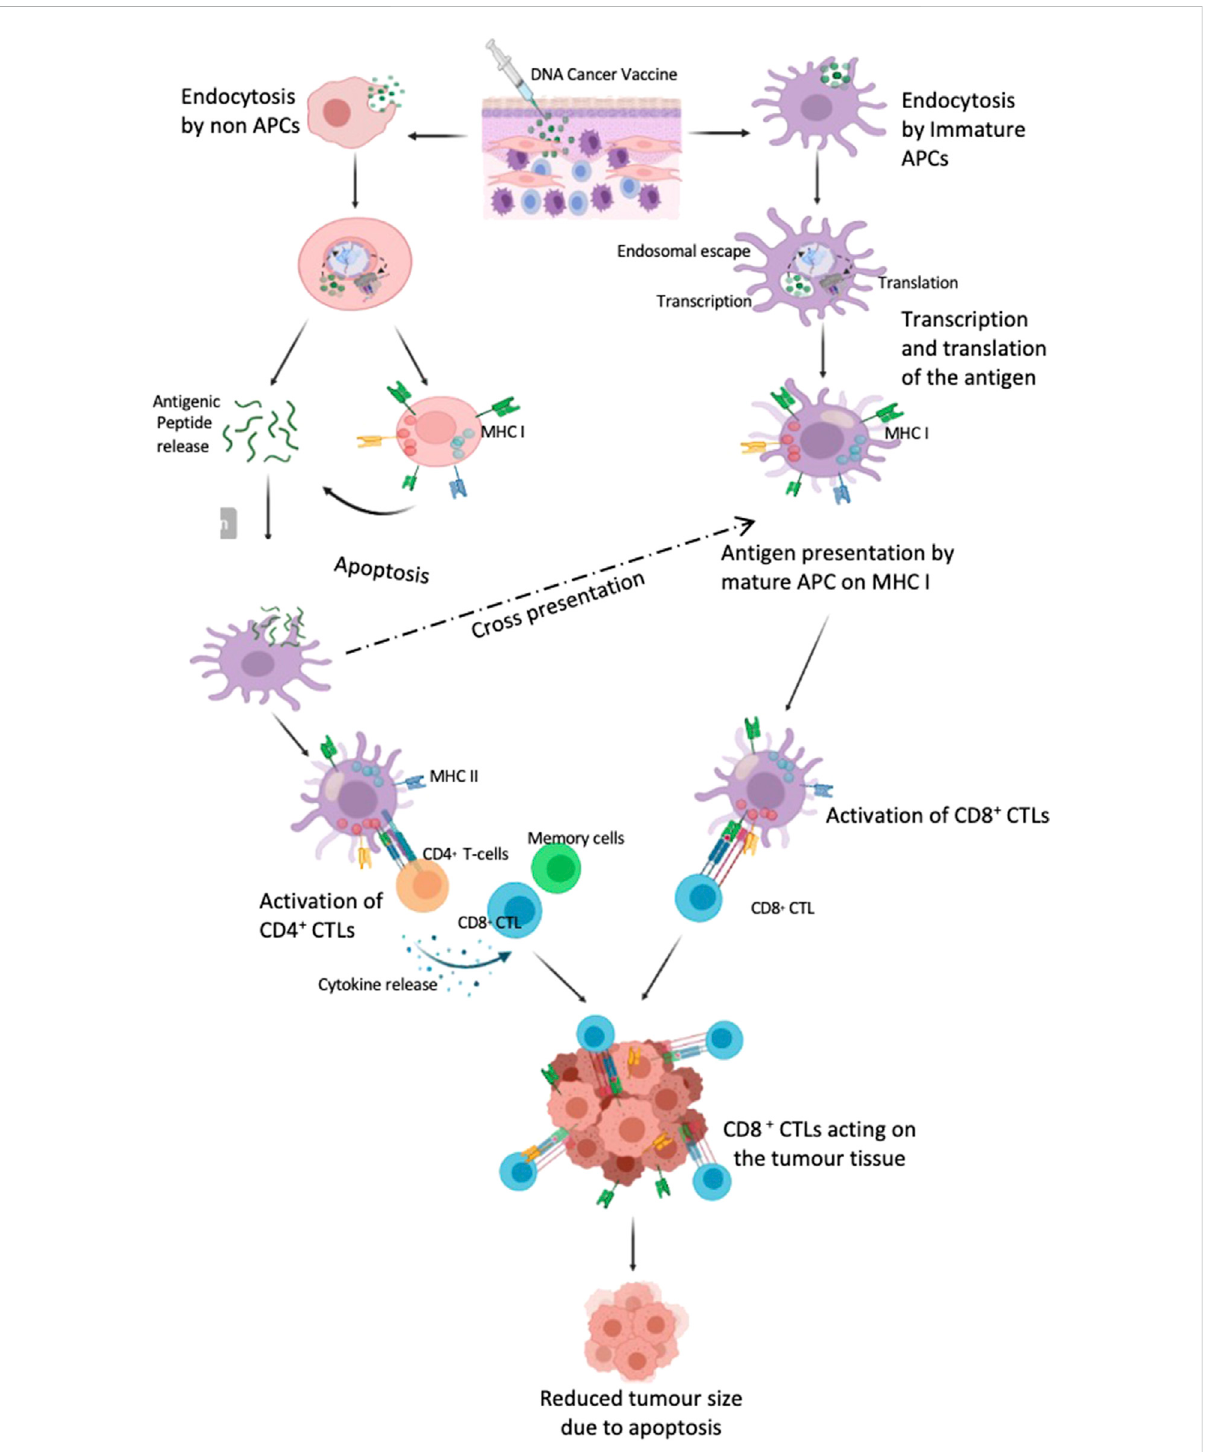
FIGURE 4 DNA vaccine targeting DC cells to induce an immune response. The vaccine is delivered intradermally where the immature APC, macrophages and other immune cells are recruited. The cargo enters the immature APC, traf fi cs to the nucleus where the RNA transcription occurs followed by protein translation in the cytoplasm and is then represented on the cellular surface as MHC I and thus matures the DC. These cells then trigger the CD8 + CTL response. However, if the plasmid is taken up by the non-APC cells, they either present them in MHC I and subsequently release the antigenic peptide on apoptosis ordirectly releasethepeptide byproteolysisbyproteosome.Thesepeptides are thentaken upby theAPC andeither cross presented in MHC I or presented on MHC II which stimulates the CD4 + T cell response which further generates CD8 + CTL and memory cells. (Created with